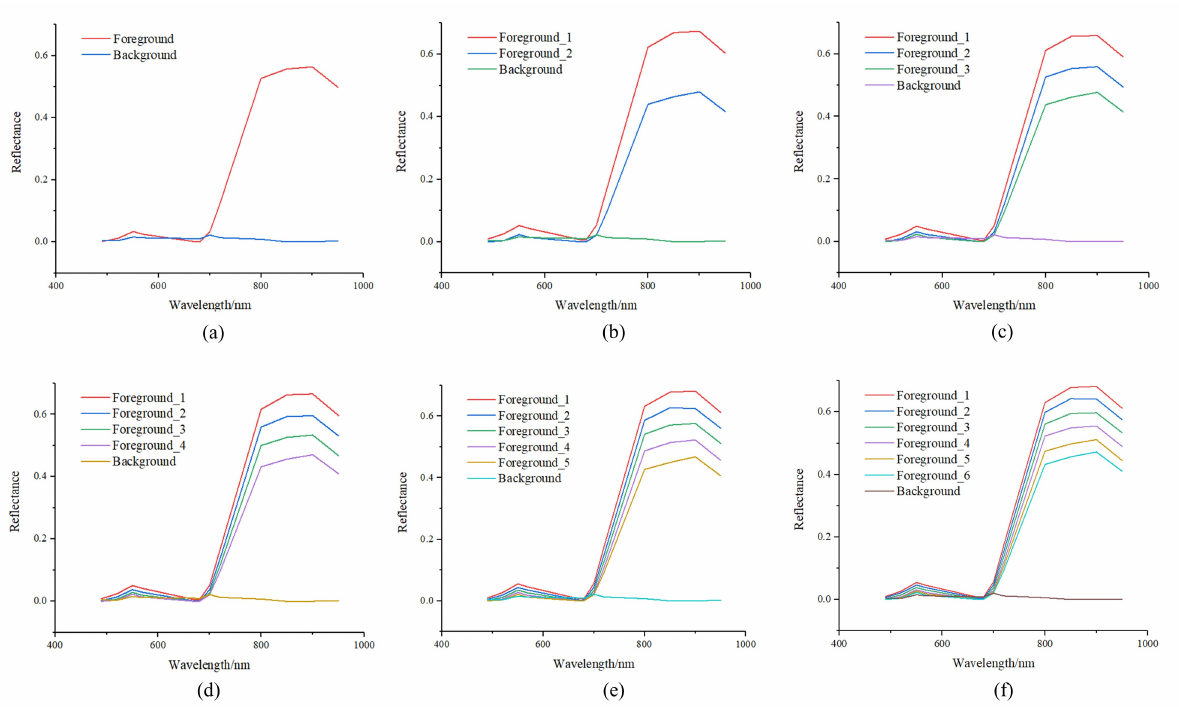
Figure 8. The output endmember spectra of the six strategies. ( a ) One foreground and one background; ( b ) two foregrounds and one background; ( c ) three foregrounds and one background; ( d ) four foregrounds and one background; ( e ) five foregrounds and one background; and ( f ) six foregrounds and one